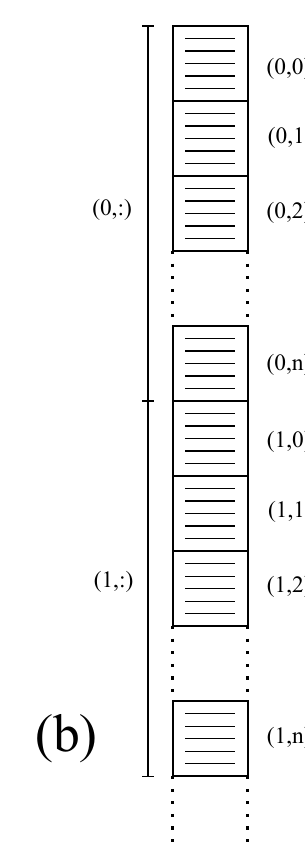
Figure 2. Reorganization of an input image ( a ) as a strip of patches ( b